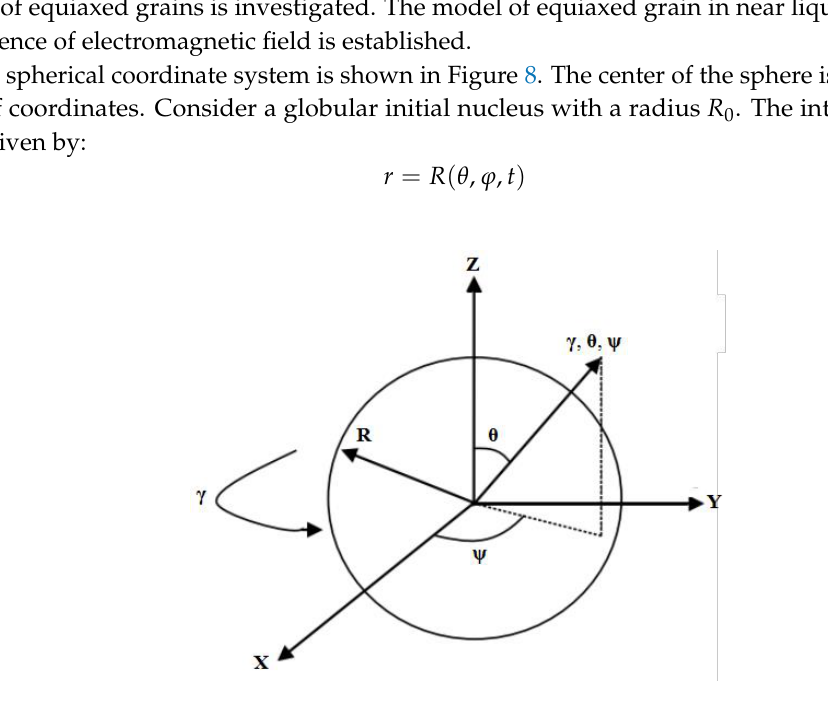
Figure 8. The spherical coordinate of undercooled melt.